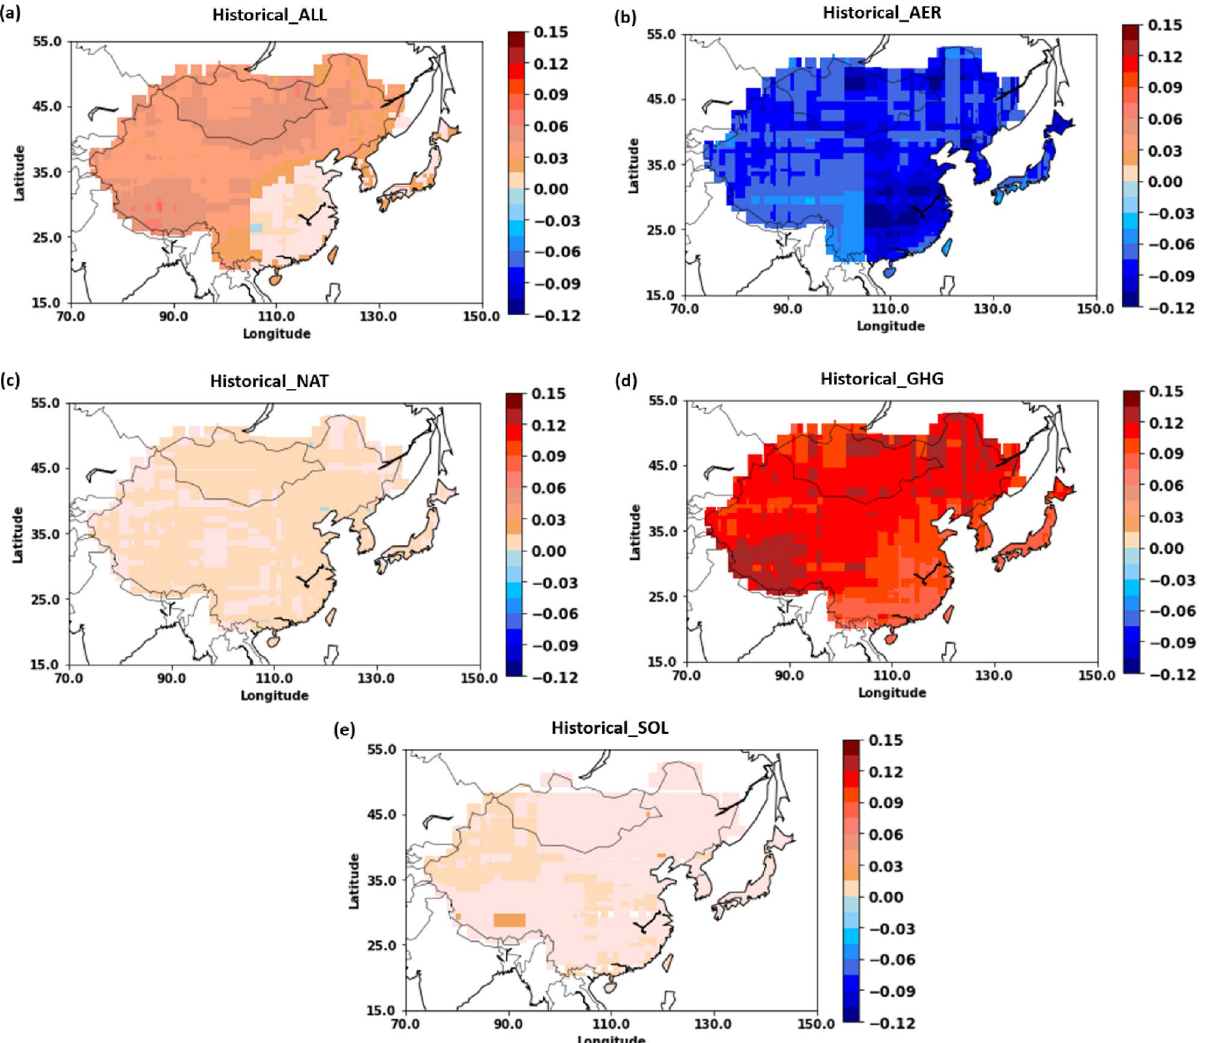
Figure 2. Spatial distribution of trends in annual mean surface air temperature responses to different forcings (°C/decade) for the historical period 1850–2014 obtained from CMIP6. ( a ) ALL, ( b ) anthropogenic aerosol (AER), ( c ) natural (NAT), ( d ) greenhouse gas (GHG), and ( e ) solar irradiance (SOL). The trends are estimated based on robust regression analysis. All figures were generated using licensed MATLAB (release R2017b available at https:// in. mathw orks. com/ produ cts/ matlab.